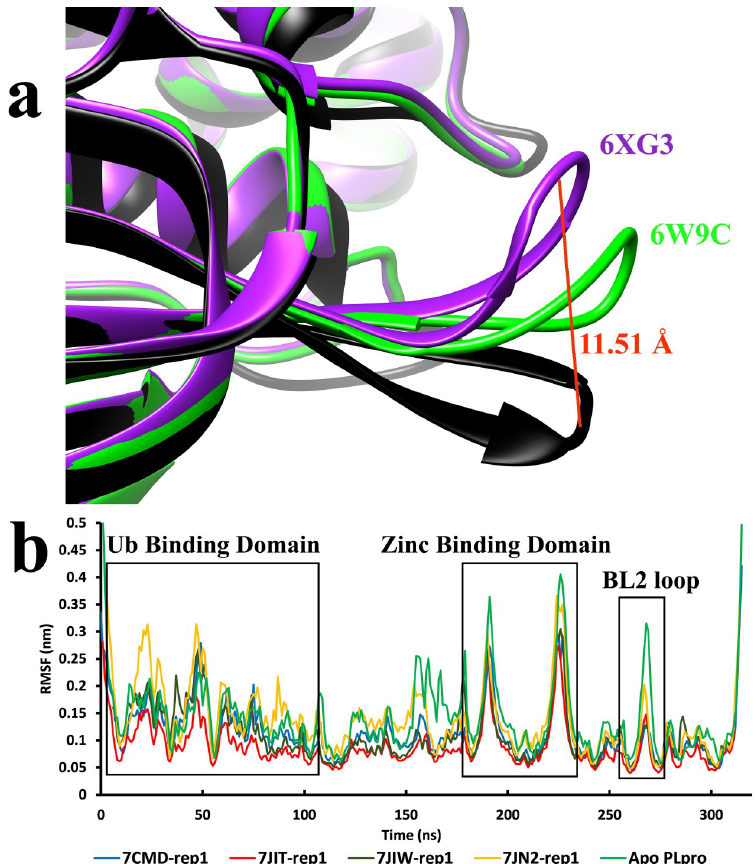
Fig 6. The flexibility of the BL2 loop. (A) the crystallographic structures of the Plpro are superimposed to compare the flexibility of the BL2 loop and the degree of its opening mechanism. The fully open structure of the BL2 (Black), which was achieved from the unbinding pathways and in the presence of the inhibitor, showed that the distance between the C α atoms of the Tyr268 on the tip of the BL2 loop in each structure reaches 11.5 Å . (B) the RMSF values of the residues of the Plpro enzyme during the unbinding pathways of the inhibitors and in the apo form of the enzyme, with respect to the important regions of the enzyme.